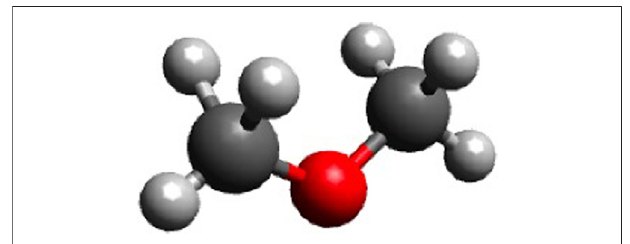
FIGURE 3 | The structure of DME (built in Avogadro,